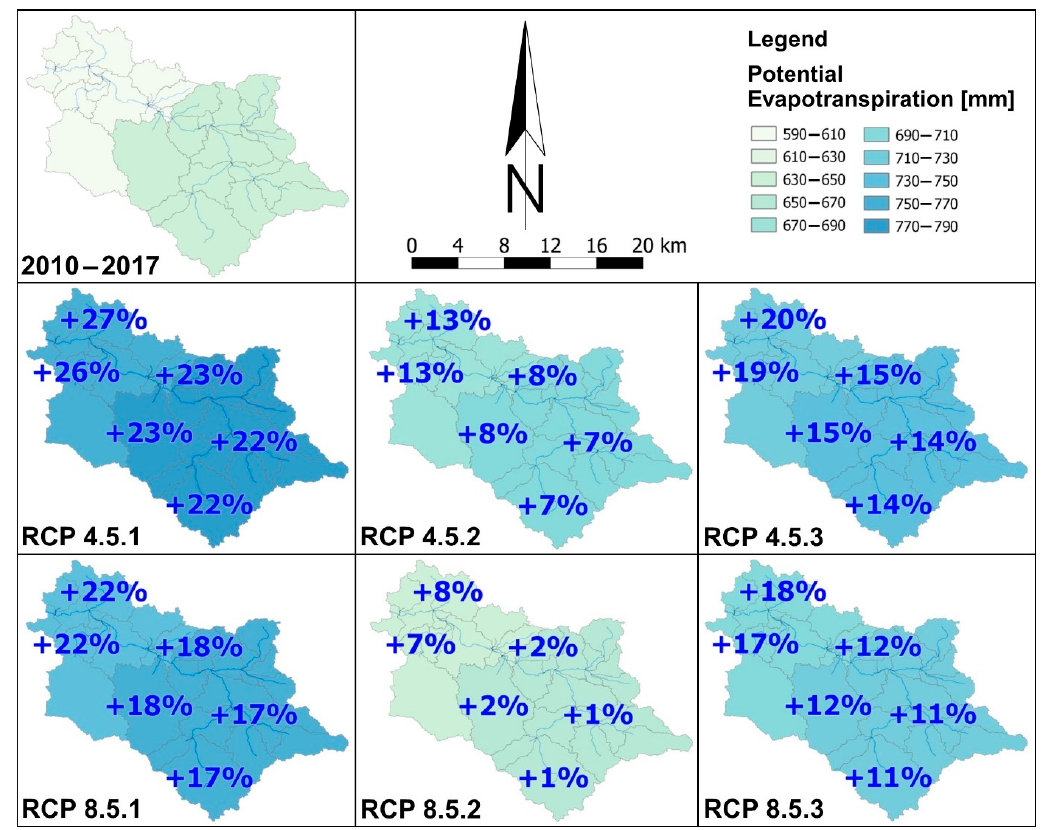
Figure 13. Comparison of the average sum of potential evapotranspiration in 31 sub-catchments for the SWAT simulation period for 2010–2017 and 2041–2050 for individual climate projections in the RCP 4.5 and RCP 8.5 scenarios (own study). The trend of the average annual total runoff consisting of surface runoff, lateral flow and baseline flow in the RCP 8.5.1, RCP 8.5.2, and RCP 8.5.3 projections will in- crease over the years 2021–2050 (Figure 14). For the RCP 4.5.2 projection, the trend will be downward. However, for the RCP 4.5.1 and RCP 4.5.2 projections, the trend will not change significantly.